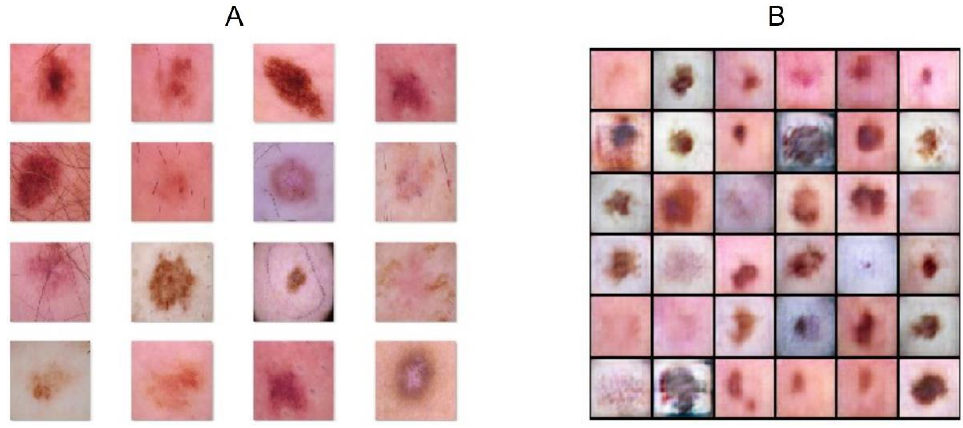
Figure 4. ( A ) Images taken from the training set. ( B ) Images generated by the architecture.